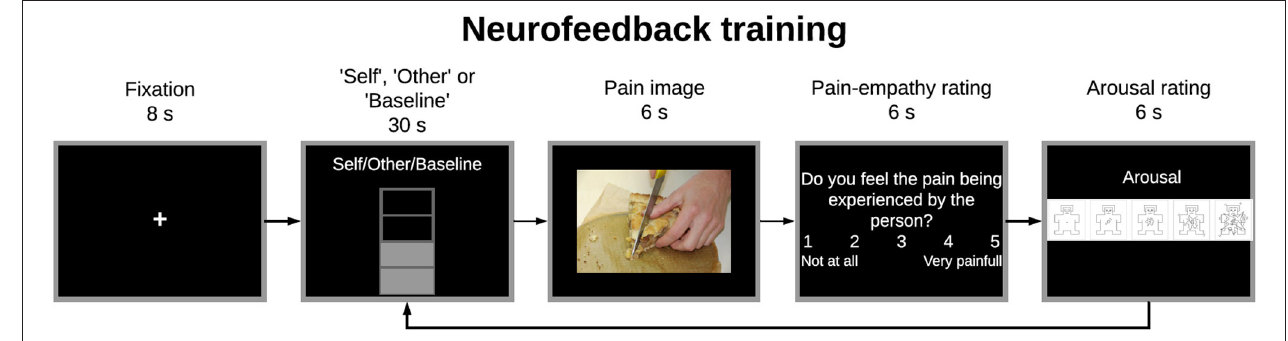
FIGURE 4 | Experimental paradigm for the train, neurofeedback training, and transfer tasks. Participants had to imagine painful situations according to the “Self”/”Other” perspective presented at the begin of the imagery block to up-regulate the brain activity of the specified region-of-interest (ROI) (30s). Then, participants viewed a potential painful picture (6s) and answered two behavioral ratings concerning pain empathy and arousal (6s per rating). In the train and transfer runs no feedback information was given during the imagery